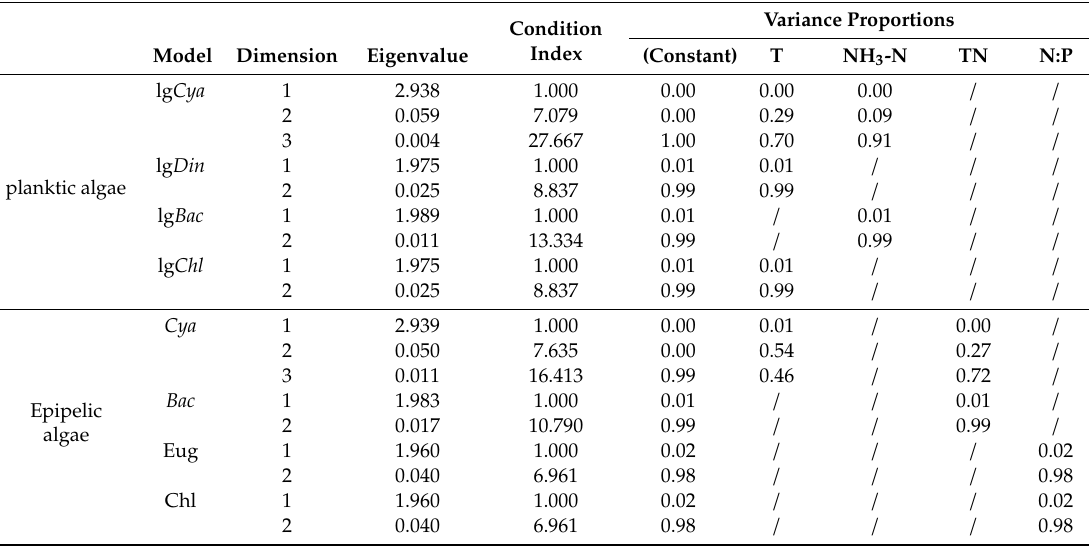
Table 7. Collinearity